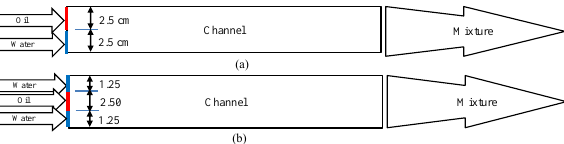
Fig. 3: Adjustment for circular to rectangular cross section